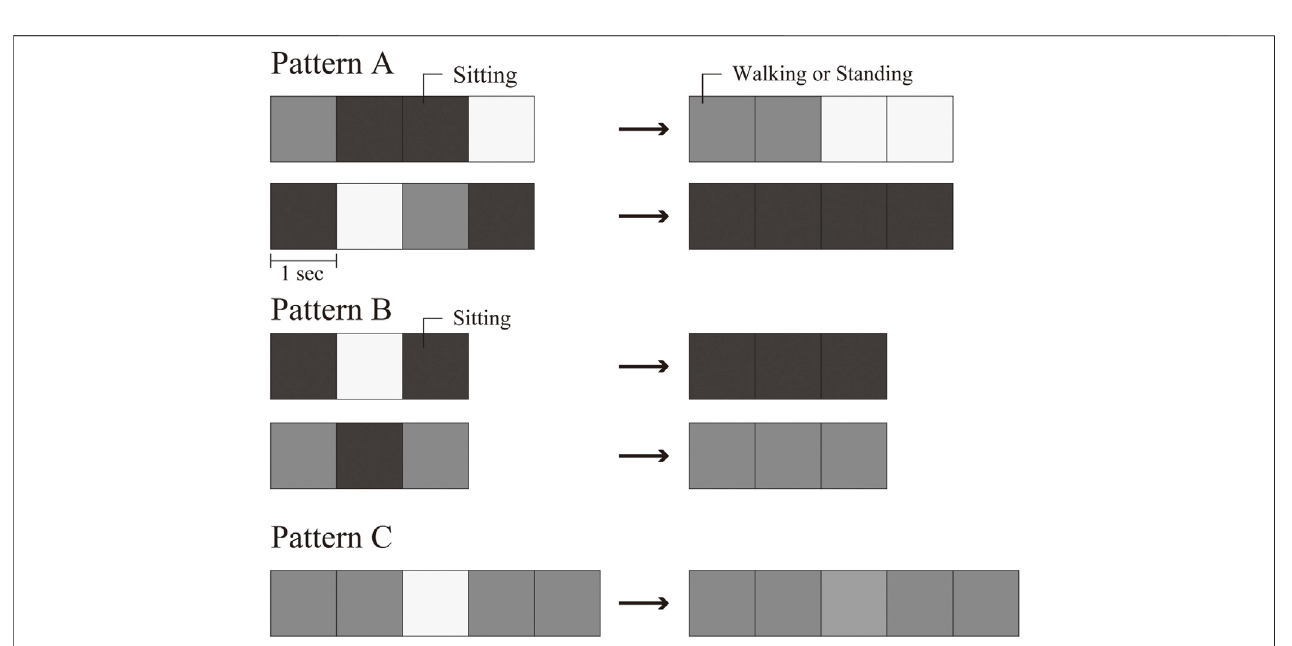
FIGURE 3 | Noise correction